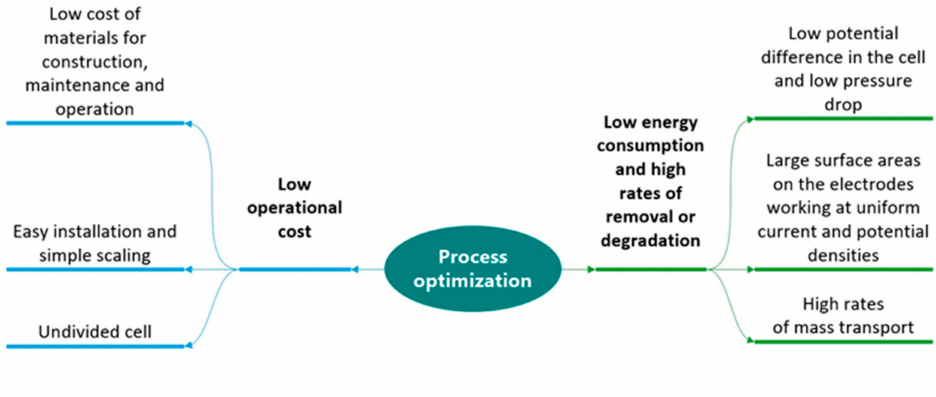
Figure 4. Characteristics of a reactor for optimization of the process in terms of operating costs, energy consumption and removal rate.